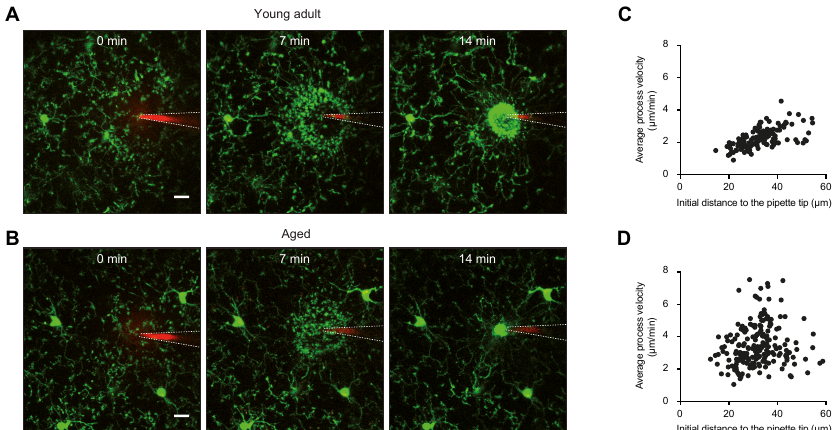
Figure 1. Microglial process extension towards an ATP source is less coordinated in the aged brain. ( A , B ) Maximum intensity projection images (80–100 µ m below the cortical surface, 2 µ m step size), obtained in vivo in the cortex of young adult ( A ) and aged ( B ) CX 3 CR1 GFP/+ mice. Images show the extension of processes of GFP-positive microglia (green) towards a pipette containing 5 mM ATP and 200 µ M of red fluorescent dye Alexa594 at three different time points (see time stamp) after ATP application. White dashed lines accentuate the locations of the pipette. ( C , D ) Scatter plots showing the relationship between the initial distance of the microglial process to the tip of the ATP-containing pipette and its average movement velocity in young adult ( C ) and aged ( D ) mice. Panels ( C , D ) are reproduced from ref.